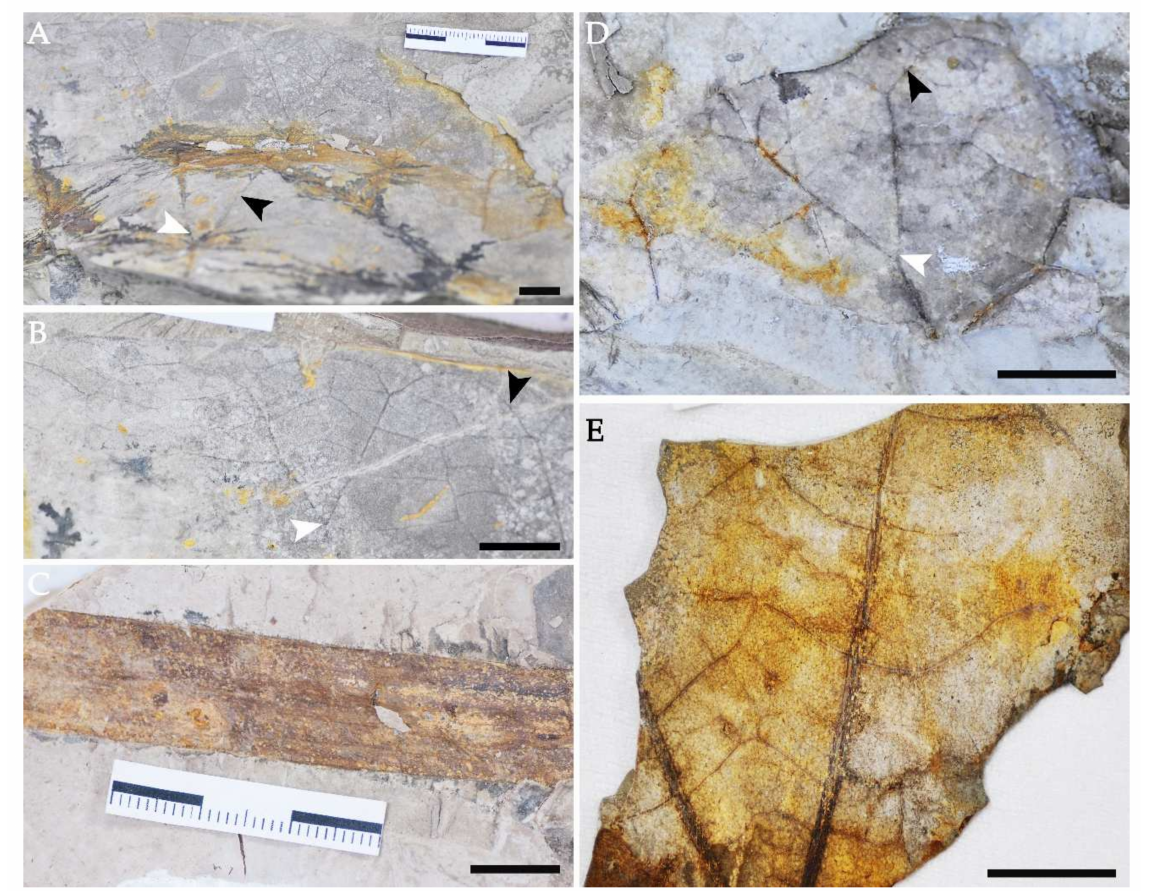
Figure 2. Leaves and fruit of Nelumbo delinghaensis from the Qaidam Basin on the Tibetan Plateau. ( A ) The general aspect of a leaf shows an orbicular and peltate lamina, radiating ribs (black arrow) from the center of leaves and the point of insertion of the petiole (white arrow). DLH550. ( B ) The counterpart leaf of ( A ) shows the position of bifurcation (white arrow) and the brochidodromous arches (black arrow). ( C ) Petiole of N. delinghaensis and its scattered small prickles, scale bar = 10 mm. ( D ) Another leaf shows the position of bifurcation (white arrow) and the brochidodromous arches (black arrow). DLH554. ( E ) Another leaf shows the mixed tertiary venation. DLH 552. scale bar = 10